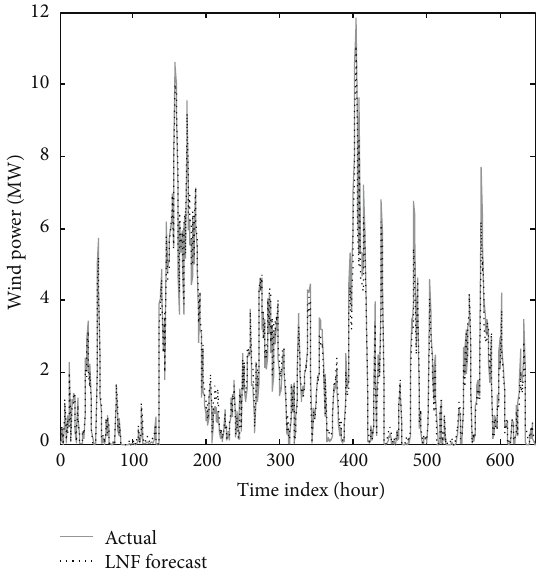
Figure 9: Actual and forecasted wind power for June 2010.